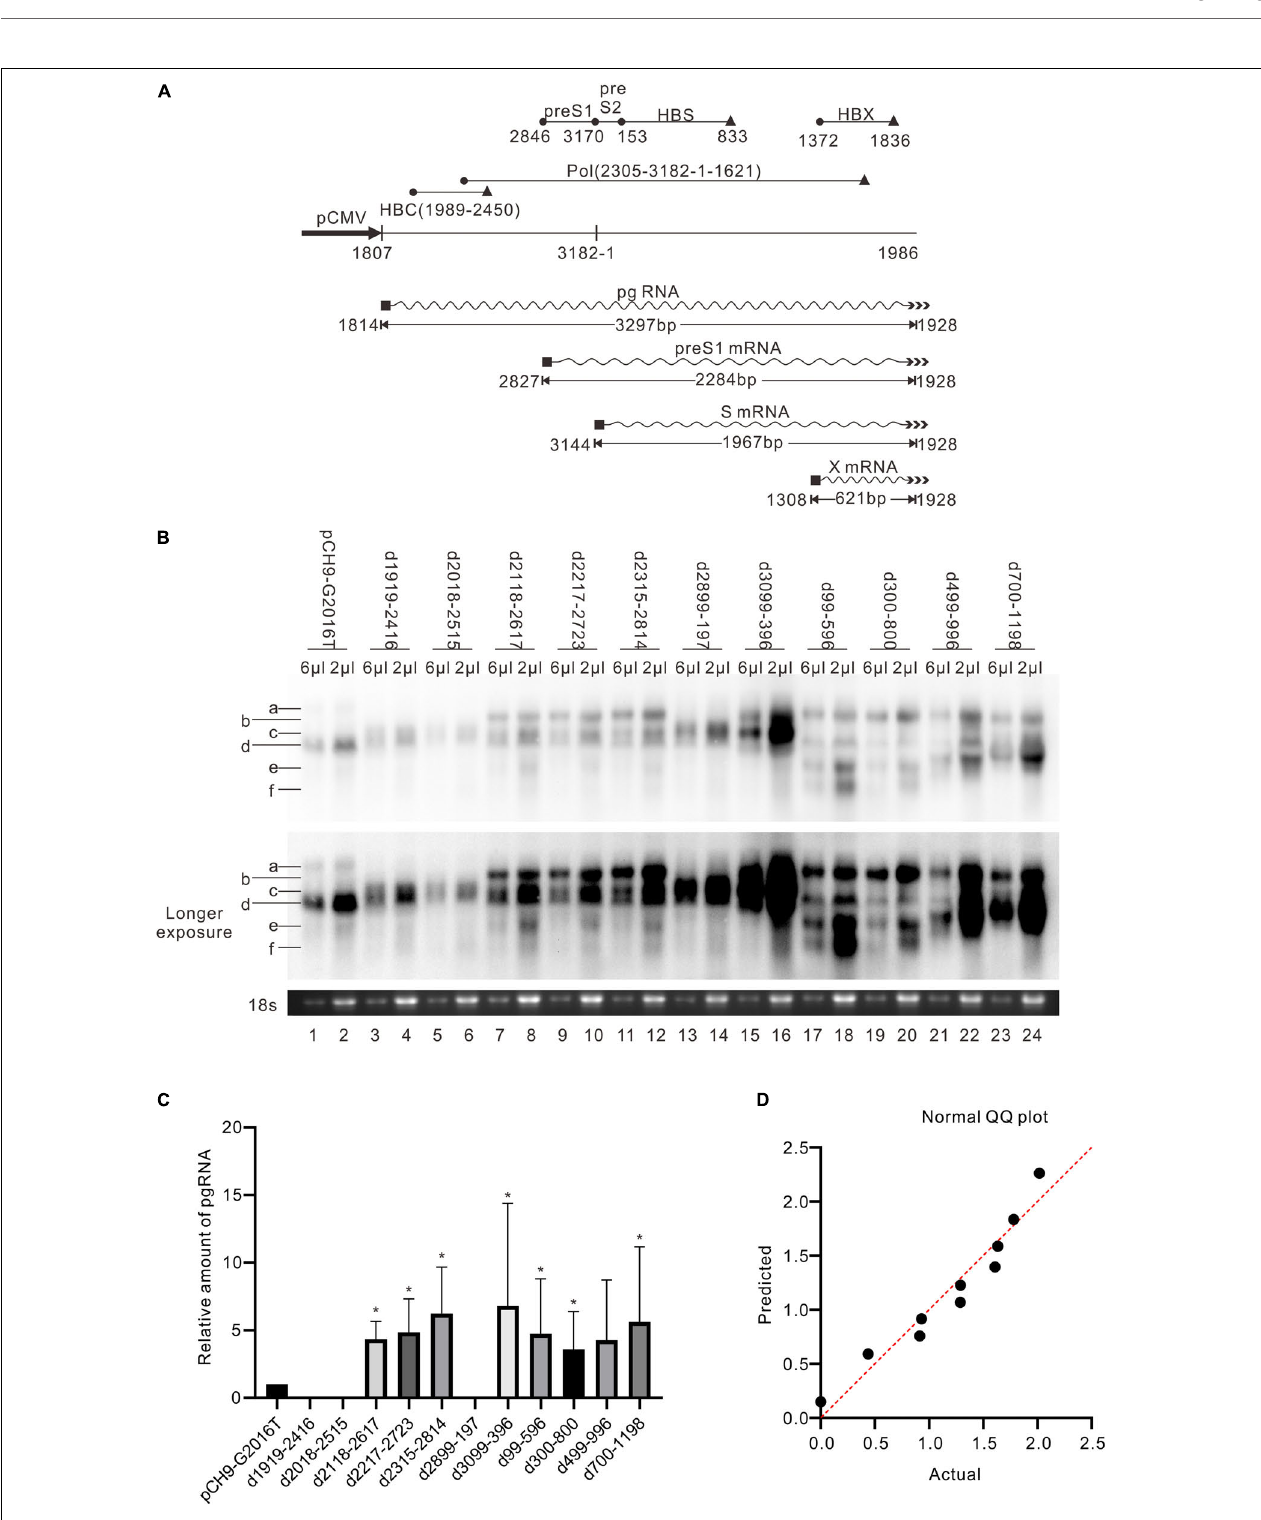
FIGURE 5 | RNA assay of the deletion variants. (A) The sequence of HBV transcripts. The wave lines represent RNA; the black rectangles represent 5 (cid:48) cap; the multiple arrowheads represent the poly-A tail. The black cycles and black triangles represent the start codon and the stop codon, respectively. The length of each transcript is an estimation without a poly-A tail. (B) Representative Northern blotting results of the deletion variants. (C) The relative intensity of pgRNA of the deletion variants. The intensity of each pgRNA/18s rRNA was divided into the sum of pgRNA/18s rRNA of all samples in the same membrane, respectively, to calculate the relative intensity of pgRNA of each sample. N = 4. Asterisks (*) denote the difference between deletion variants and pCH9-G2016T is significant ( p < 0.05). (D) Normal QQ plot of the relative amount of the pgRNAs.